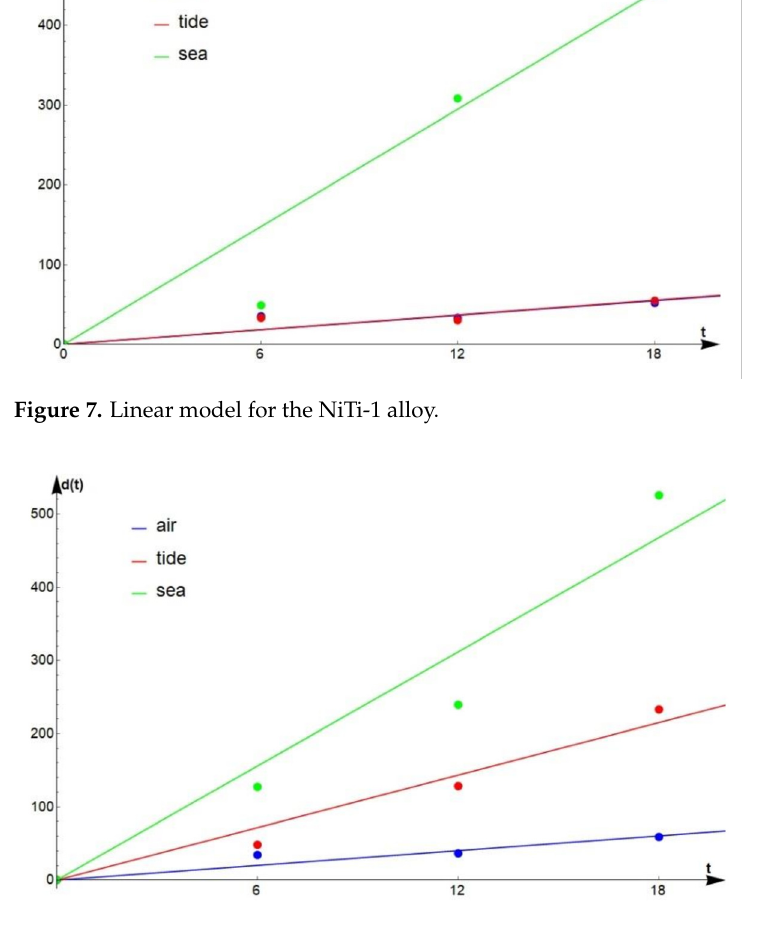
Figure 8. Linear model for the NiTi-2